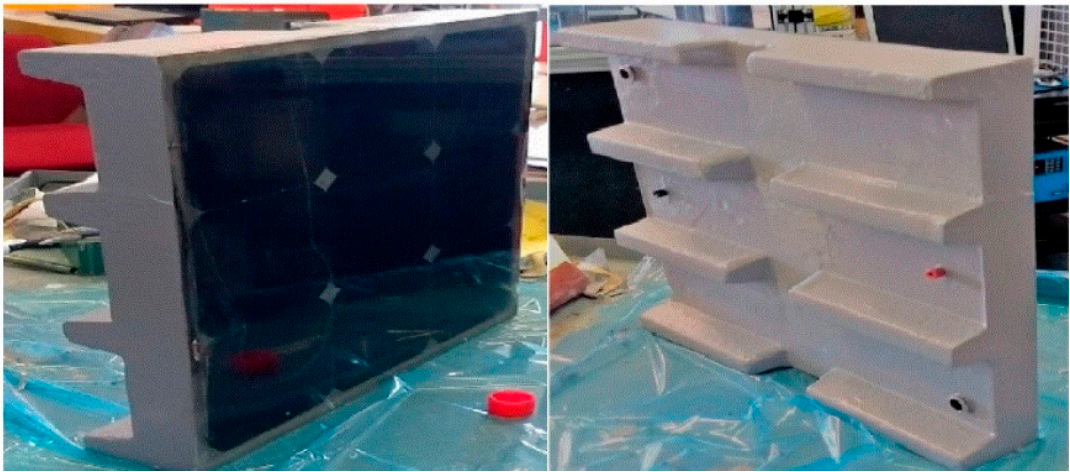
Figure 6. Photovoltaic cells, heat sink enclosed in transparent and opaque resins with on left hydraulic and electrical connectors [113].